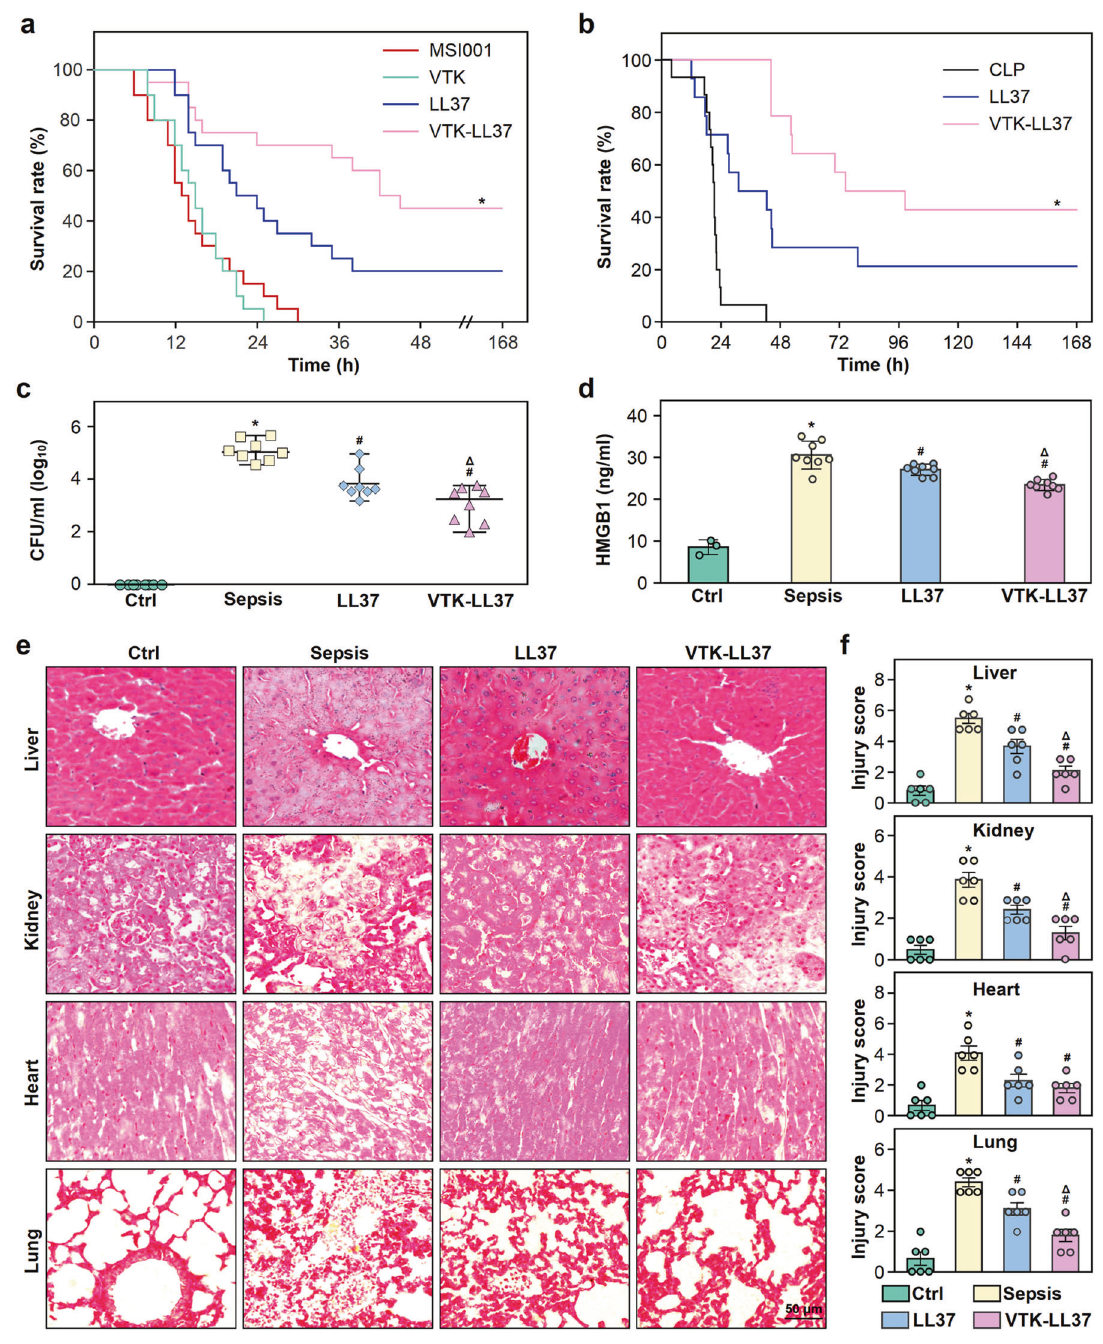
DISCUSSION Clinical epidemiological investigation shows that 95% of sepsis in patients is caused by bacterial infections, and early antibacterial therapy is important for increasing the survival of patients with sepsis. 37,38 Various bacteria, including Salmonella, Klebsiella pneumonia , Listeria monocytogenes , Staphylococcus aureus , Bacillus genus , Hemophilus , E. coli, Pseudomonas aeruginosa , Streptococcus viridans , and Coagulase-negative staphylococcus , have been reported in sepsis. However, different bacteria have